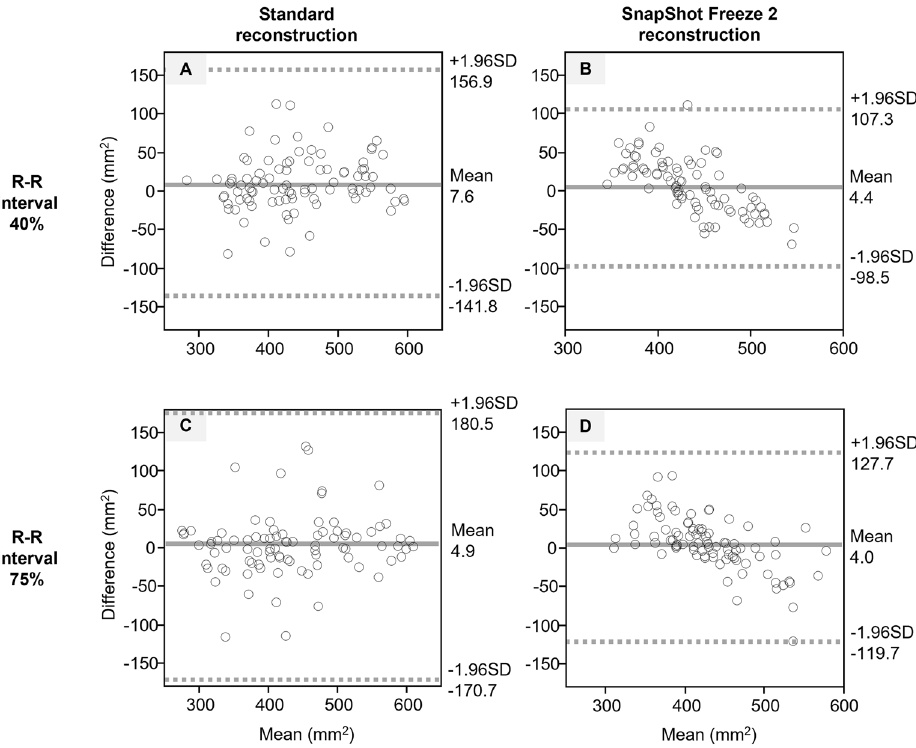
Figure 3. Bland–Altman plot analysis of the interobserver agreement with respect to the aortic annulus areas. Standard- and SSF2 reconstruction at an R-R interval of 40% ( A and B ) and standard- and SSF2 reconstruction at an R-R interval of 75% ( C and D ). The solid line represents the mean difference, the dashed lines represent the 95% limit of agreement (mean difference ± 1.96 SD). SD = standard